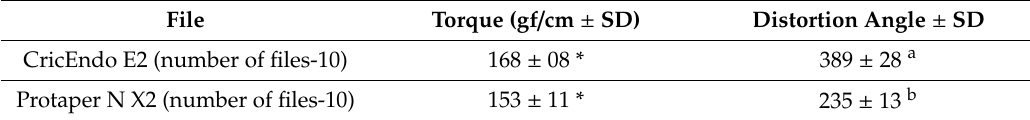
Table 2. Data obtained after torsional resistance